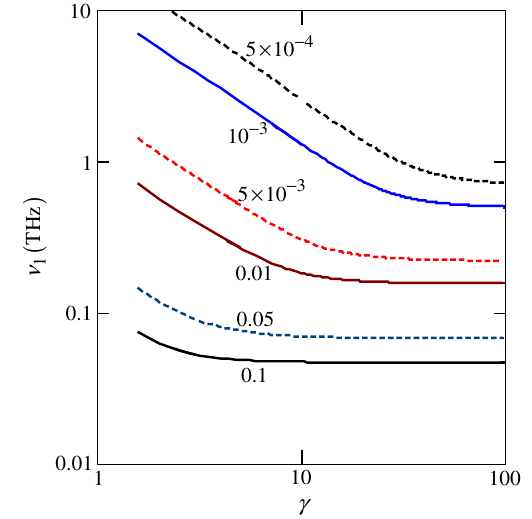
FIG. 2. The first mode frequency depending on the Lorentz factor for a waveguide with radius a ¼ 5 mm and a dielectric layer with permittivity " ¼ 4 ; the magnitudes of d=a are given near the curves.